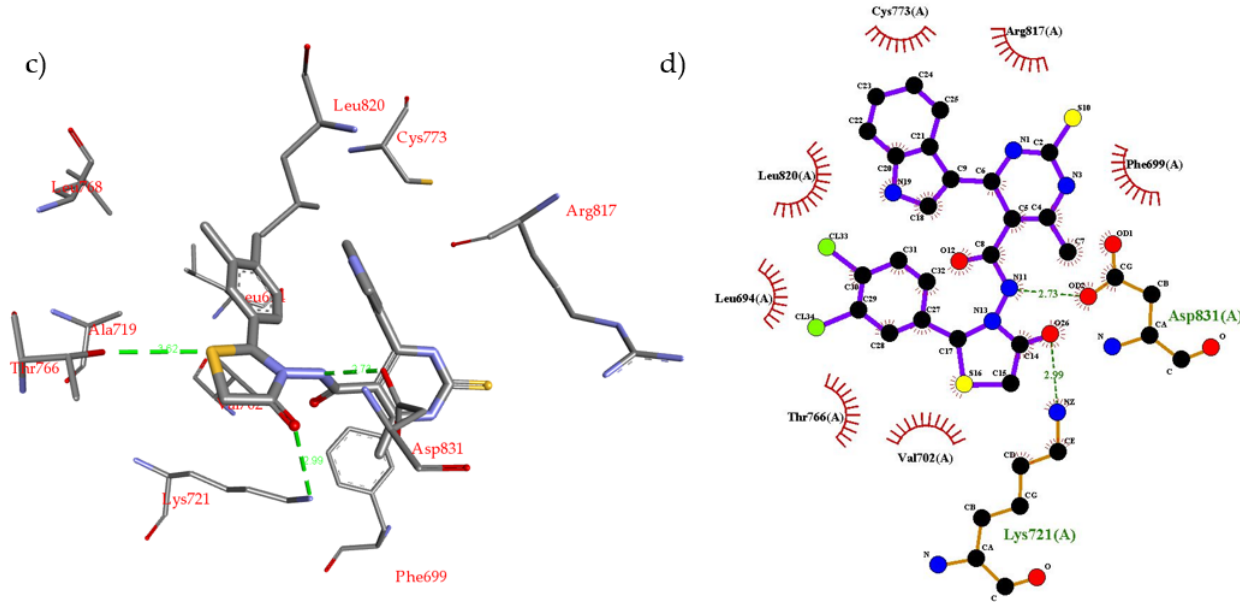
Figure 4. ( a ) Non-covalent interactions of erlotinib inside the EGFR active site; ( b ) 2D schematic representation of erlotinib inside the EGFR binding site; ( c ) non-covalent interactions of docked compound 4g inside the EGFR active site; ( d ) 2D schematic representation of compound 4g inside the EGFR binding site.